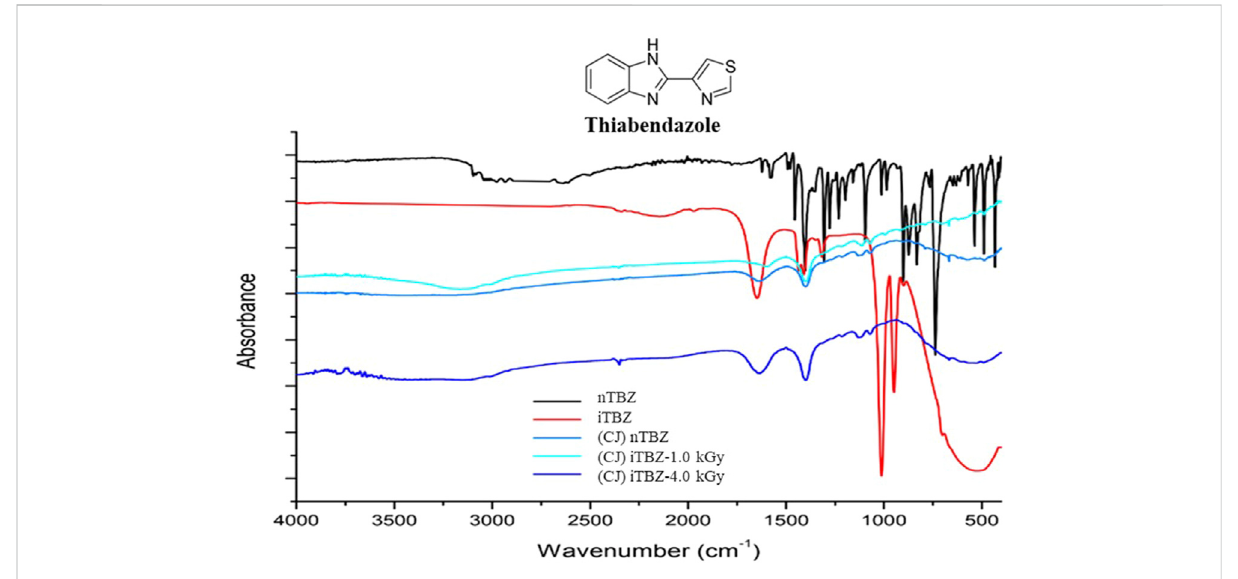
FIGURE 5 Fourier transform infrared (FT-IR) spectrum of nTBZ, iTBZ before bioelectrochemical experiments and nTBZ, iTBZ-1.0 kGy and iTBZ-4.0 kGy after bioelectrochemical experiments with CJ as